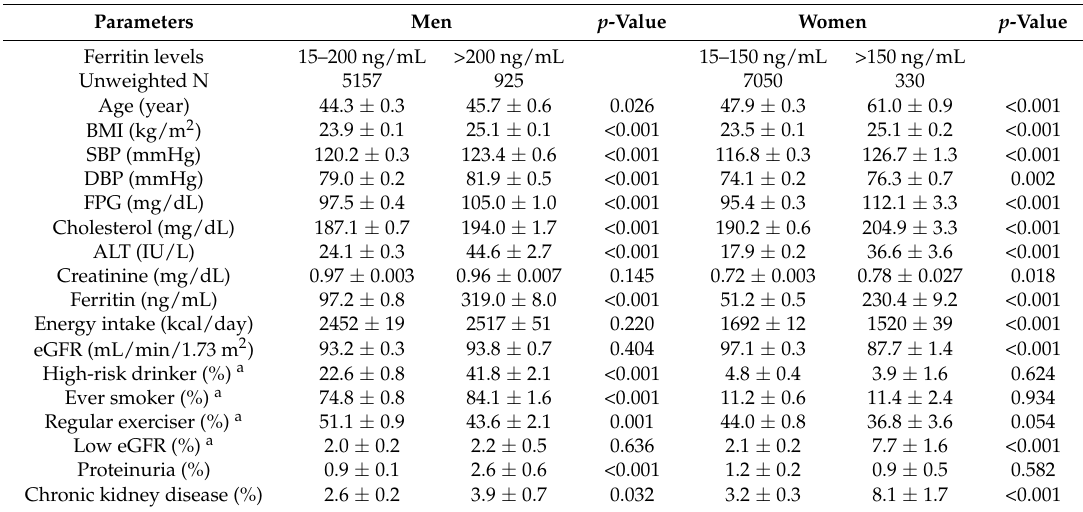
Table 2. Subject characteristics according to ferritin levels.